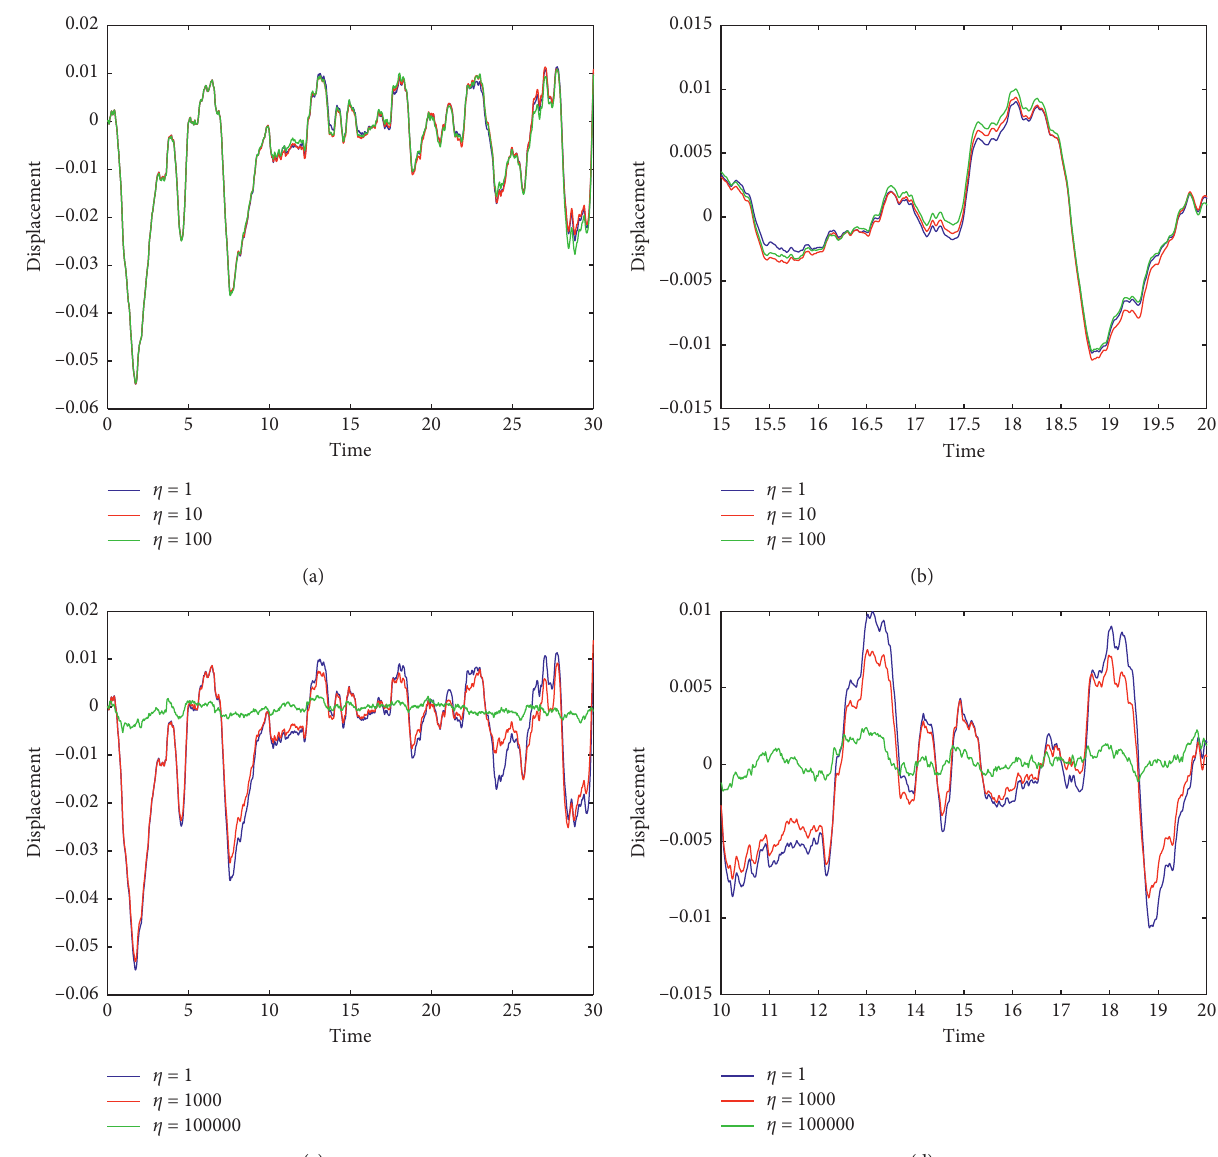
Figure 12: The variations in horizontal displacement for different values of η and λ � 1. (a) The variations in horizontal displacement for η � 1, η � 10, and η � 100 and λ � 1. (b) Detailed view of Figure 12(a). (c) The variations in horizontal displacement for η � 1, η � 1000, and η � 100000 and λ � 1. (d) Detailed view of Figure